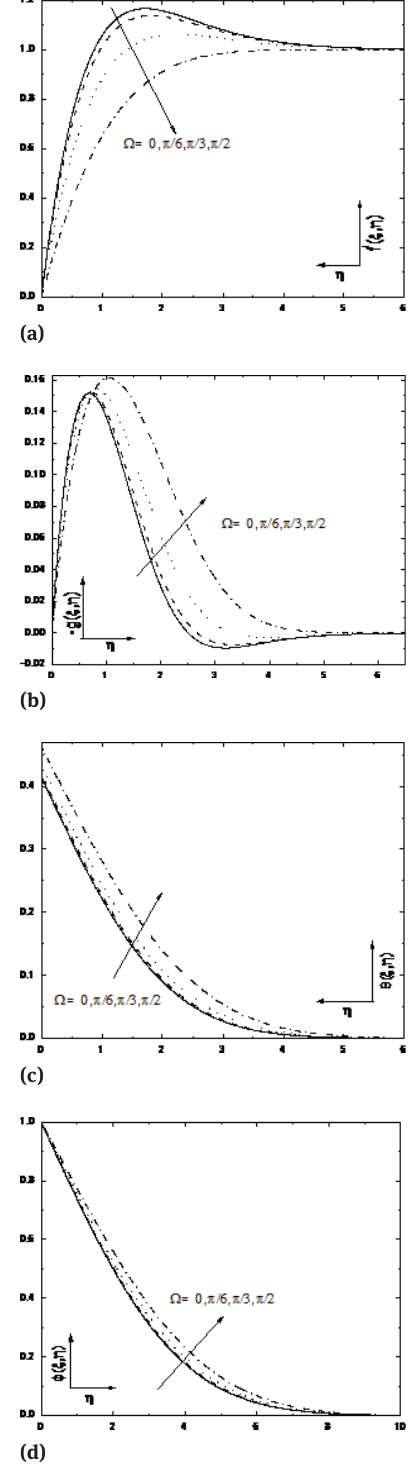
Fig. 5: Effect of inclination of angle on the (a) velocity, (b) micro- rotation, (c) temperature and (d) concentration for Δ = 1.0, Fs